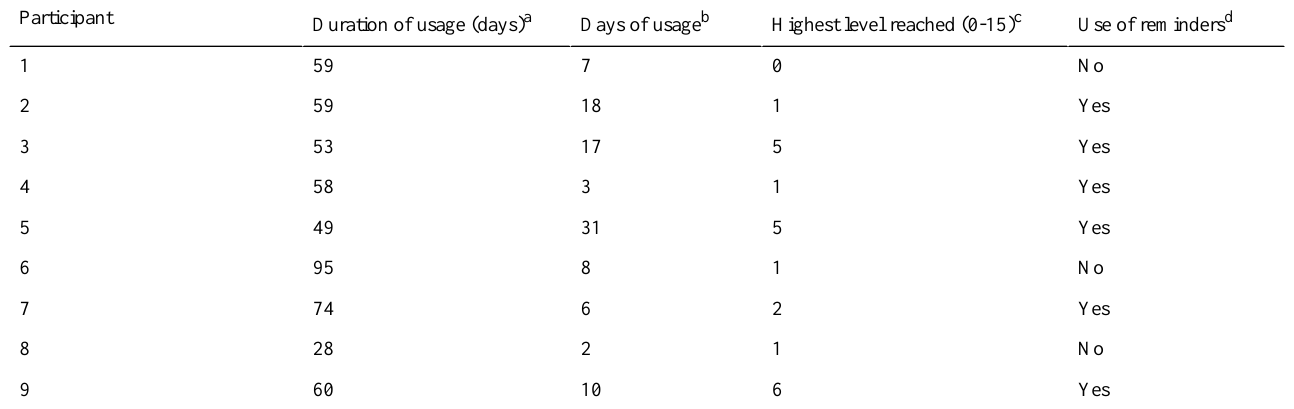
Table 2. Overview of the log